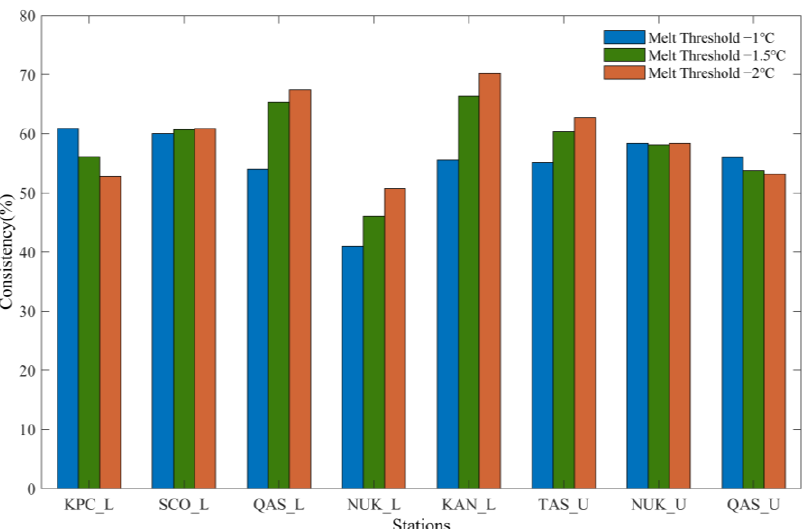
Figure 11. Consistency of melt conditions (BB) between MODIS and station based on the melt threshold − 1 °C, − 1.5 °C, and − 2 °C.